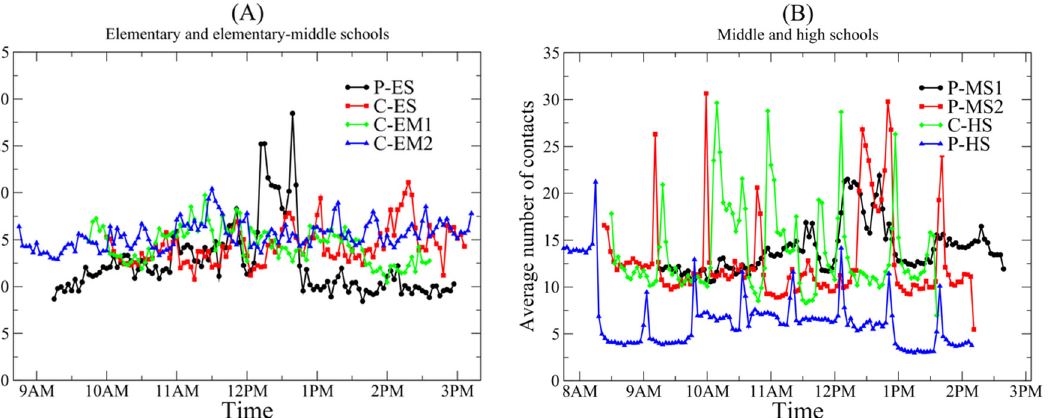
Fig 3. Average number of contacts (degree) for 3-minute intervals for the duration of the deployment. A) Elementary and elementary-middle schools B) Middle and high schools. C: Charter school; P: Public school; ES: Elementary school; EM: Elementary-middle school; MS: Middle school; HS: High